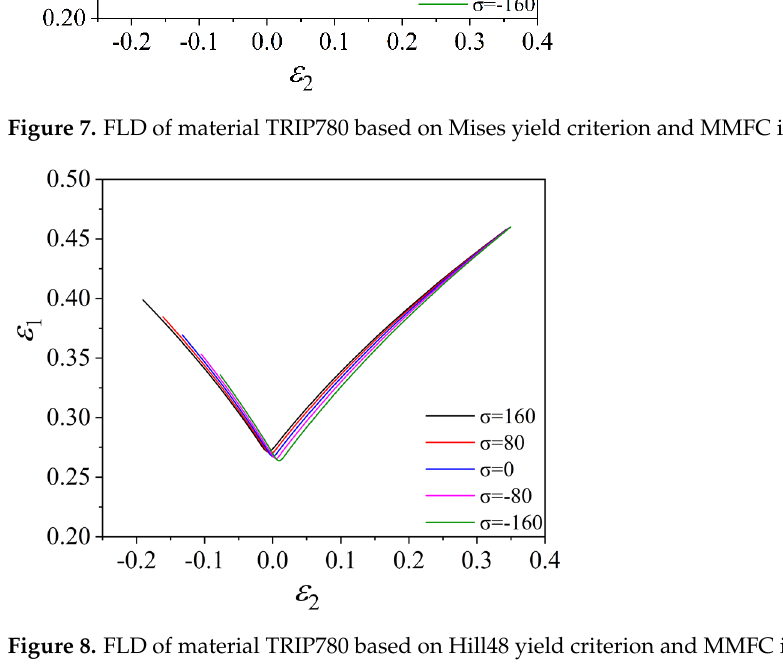
Figure 8. FLD of material TRIP780 based on Hill48 yield criterion and MMFC instability criterion.